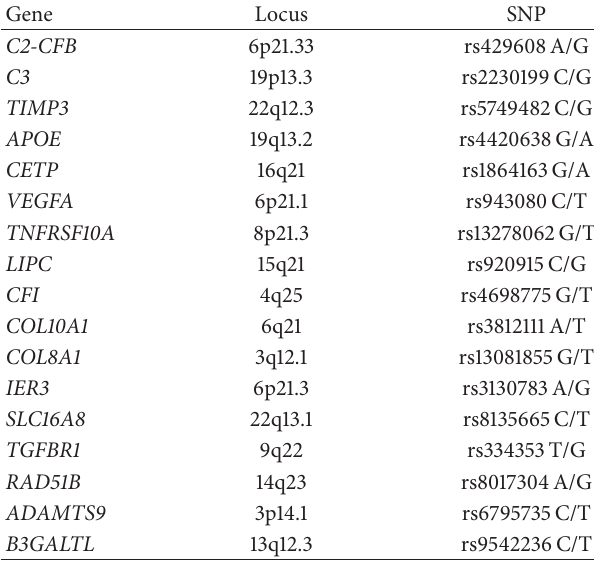
Table 1: Candidate genes involved in AMD pathogenesis, following GWAS.